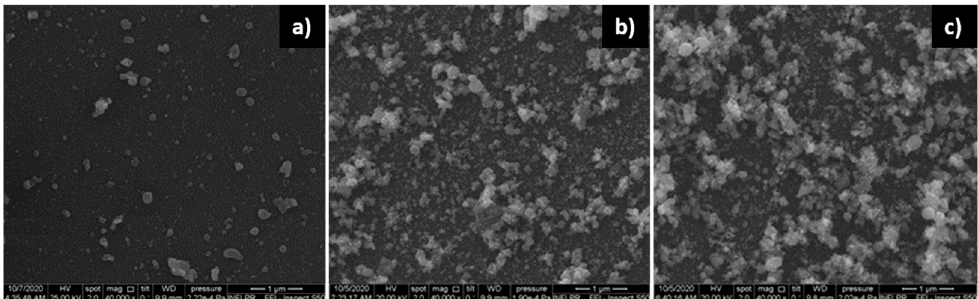
Figure 2. SEM images of ZnO films deposited using a ps laser, a wavelength of 532 nm, a power of 0.2 W and a pulse repetition rate of 10 kHz. The O 2 pressure used was ( a ) 100 mTorr; ( b ) 400 mTorr; ( c ) 700 mTorr.